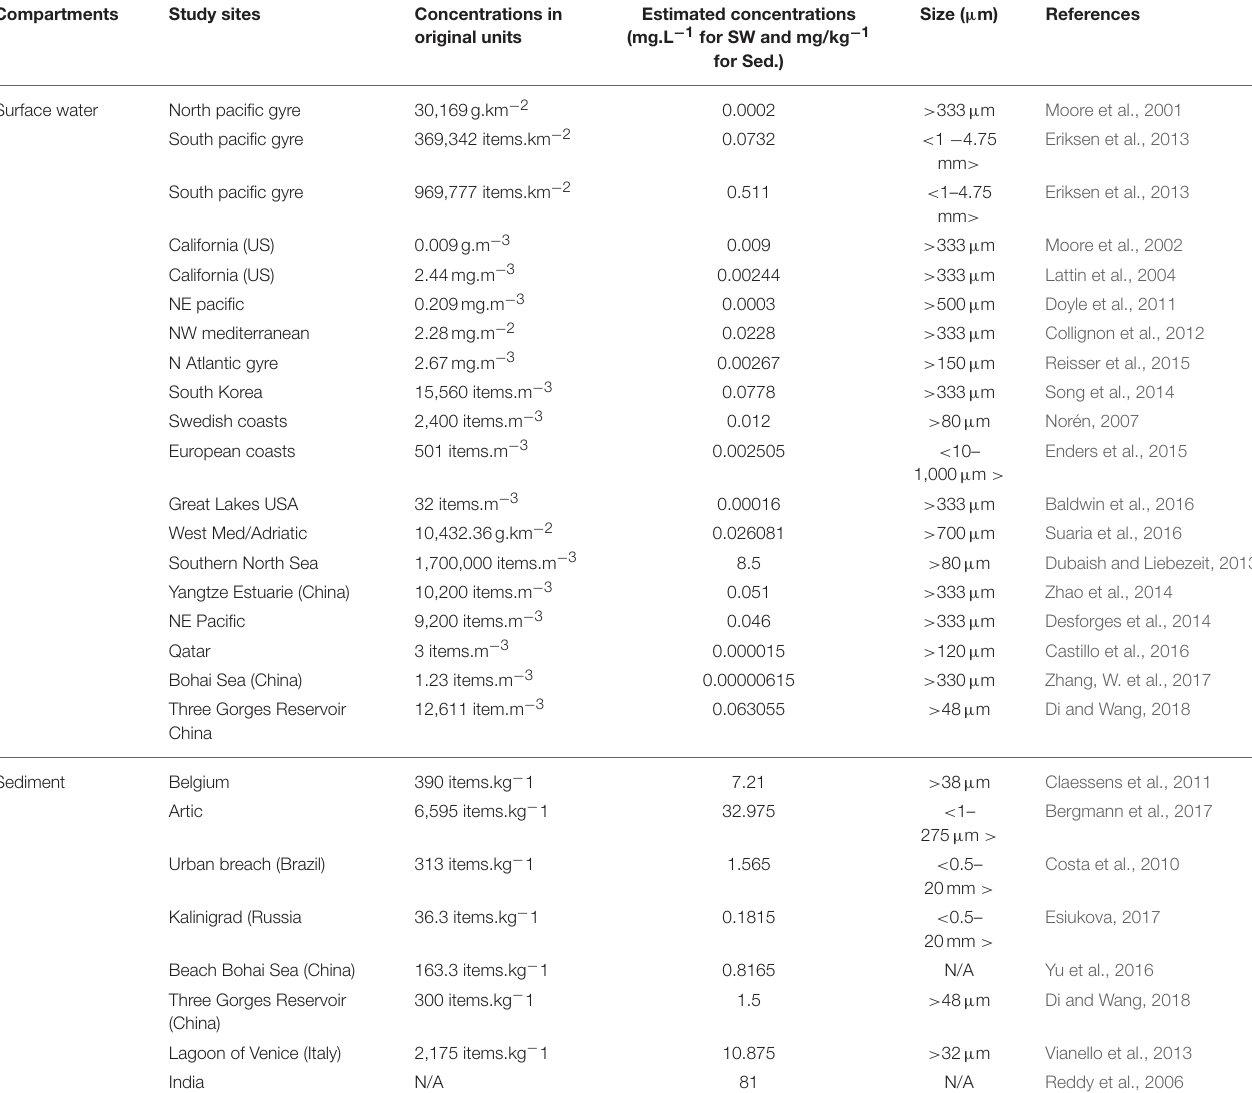
TABLE 1 | Environmental concentrations of microplastics in surface water (SW) and sediment (Sed). Compartments